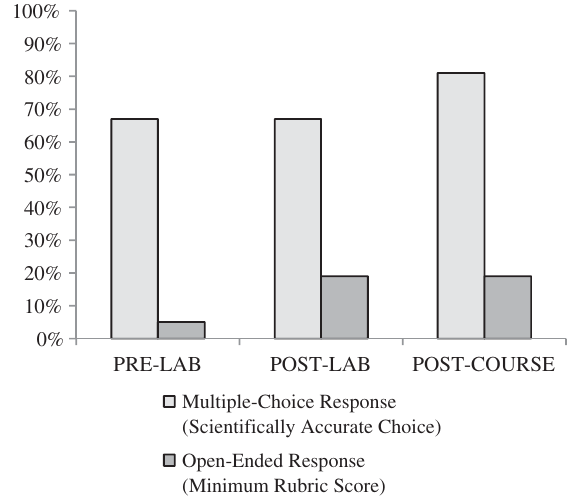
FIG. 4. Percentage of students meeting minimum criteria when asked about the portion of the celestial sphere visible from different latitudes ( n ¼ 21 ).